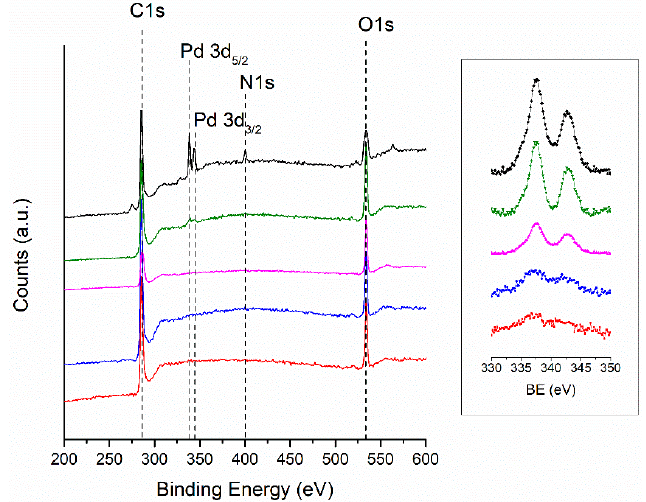
Figure 6. Survey XPS spectrum of the PdAS complex and PdAs(x)-MA catalysts (Pd 3d region; inset). Lines, PdAS complex (black), PdAS(1)-MA (red), PdAS(2)-MA (blue), PdAS(5)-MA (magenta) and PdAS(10)-MA (green).